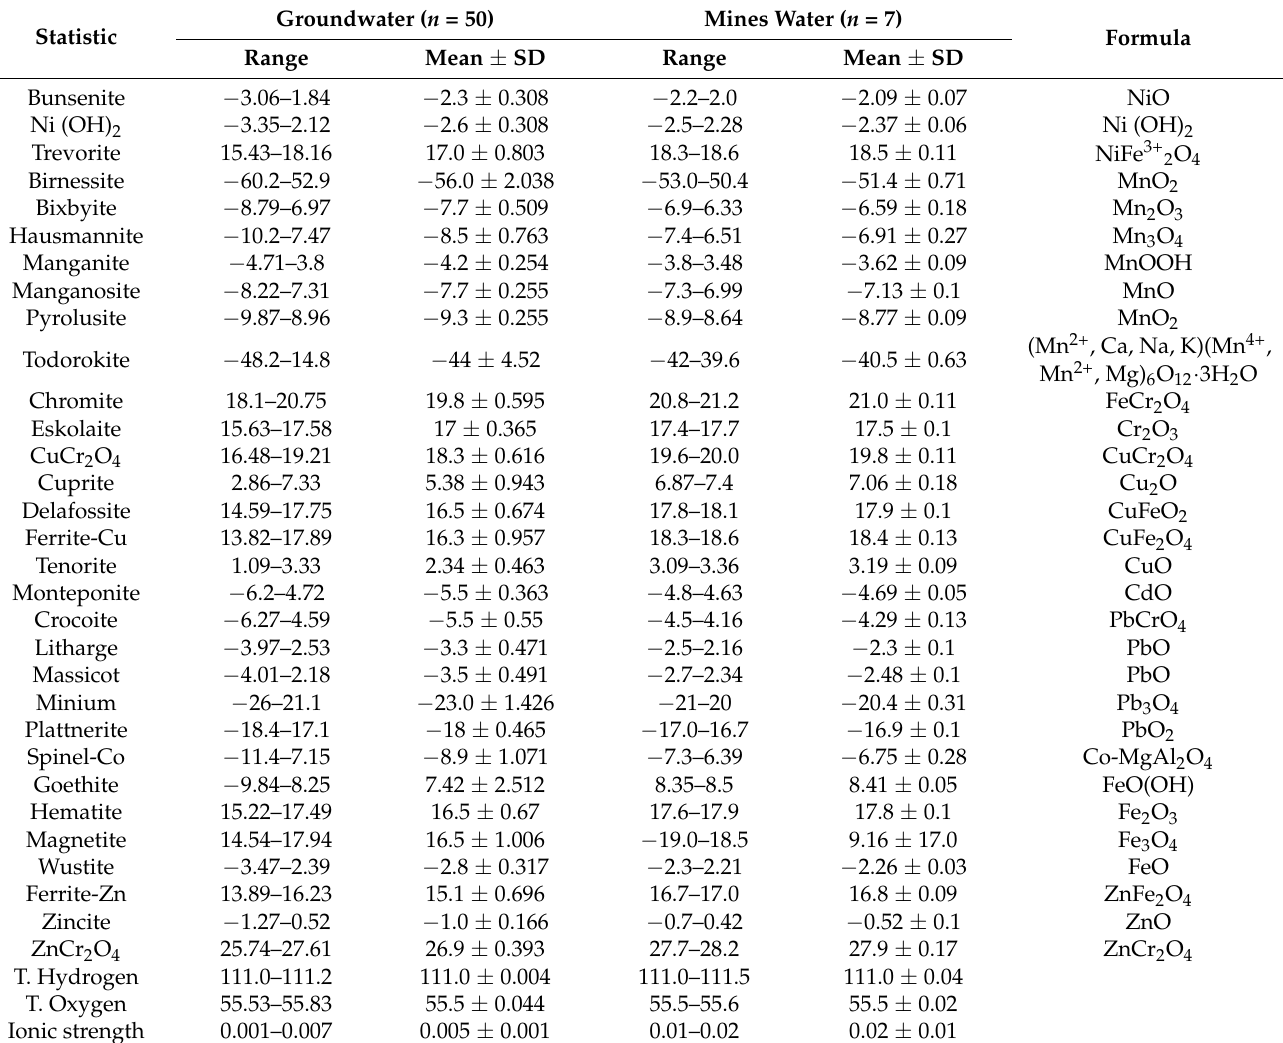
Table 3. Mineral phases of groundwater in comparison with mine water in the Adenzai flood plain